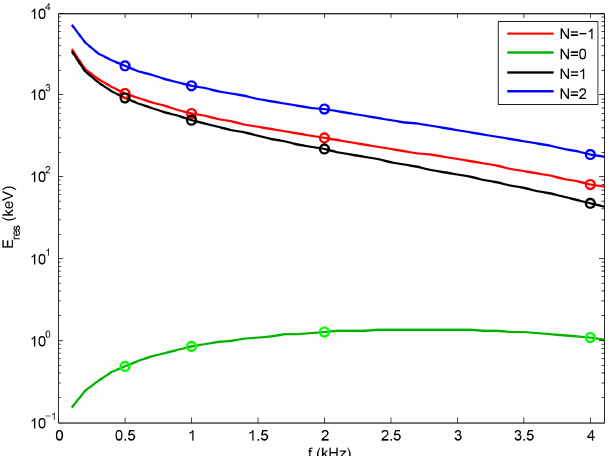
Figure 4. Electron resonant energies as a function of wave fre- quency at the magnetic equator of L = 3 for four resonance har- monics when the electron pitch angle is fixed as 30 ◦ . The red spots mark the resonant energies for four specified wave frequencies (i.e., 0.5, 1, 2, and